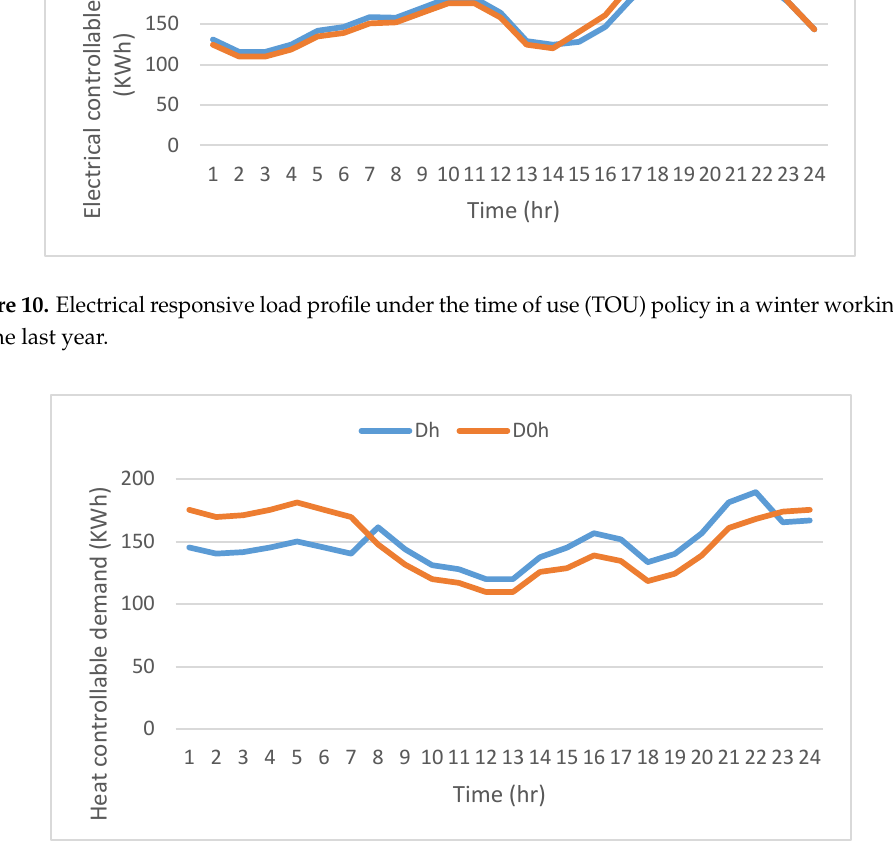
Figure 11. Thermal responsive load profile under the TOU policy in a winter working-day for the last year.